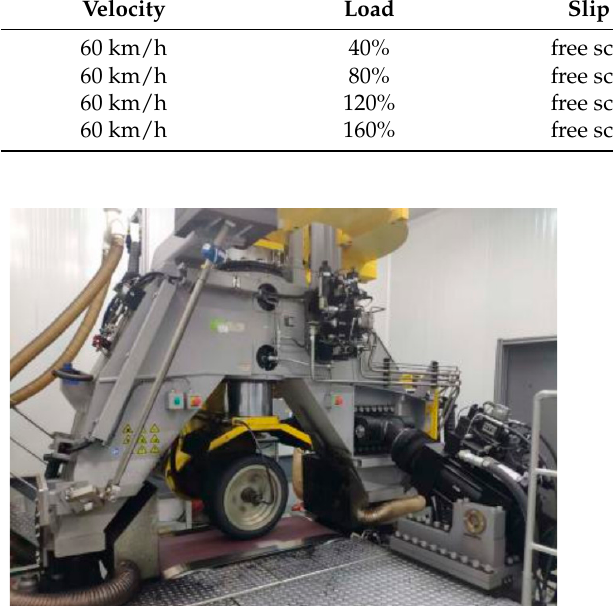
Figure 3. Tire force and moment test bench. Table 2. Tire force pure longitudinal slip test conditions.